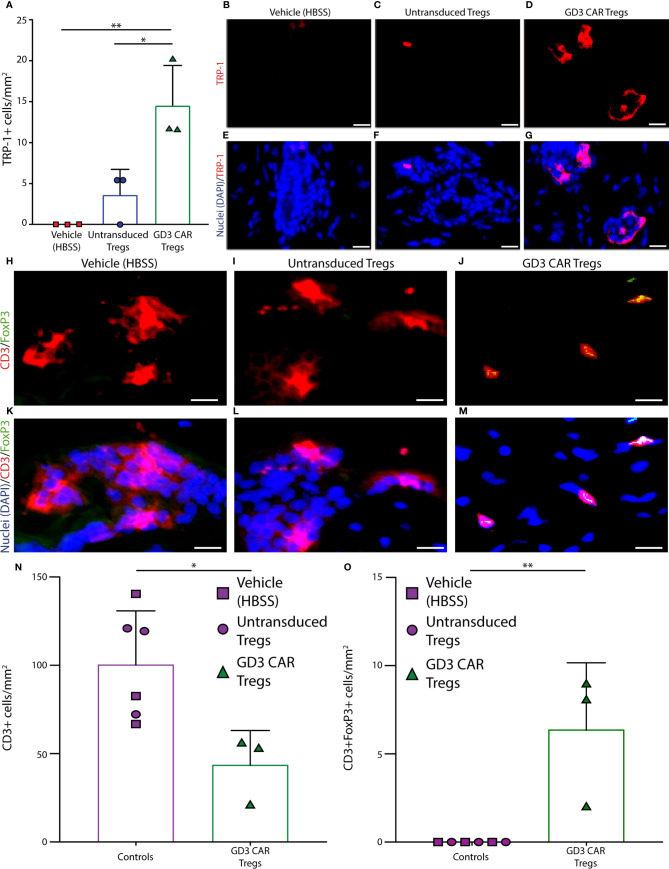
Melanocytes are protected from h3T cytotoxic T cells in the presence of GD3 reactive CAR Tregs. Mouse skin was evaluated for melanocyte presence using antibodies to TRP-1. (A) Quantification of melanocytes, as well as accompanying representative images of TRP-1 staining from (B) HBSS vehicle, (C) untransduced Tregs, and (D) GD3 CAR Tregs treated mice (n = 3 per group), with (E–G) the respective overlay including DAPI nuclear staining in blue is shown. Mouse skin tissues were also evaluated for T cell infiltration using antibodies to CD3ϵ and FoxP3, and examples of staining in skin from (H) vehicle control, (I) untransduced Tregs, and (J) GD3 CAR Tregs administered mice are shown. Representative samples were used to quantify CD3ϵ+ T cells (red), FoxP3+ cells (green), and double positive Tregs; (K–M) respective overlays with DAPI (blue) are also shown. Quantification of skin staining ± SD (n = 3 per group) for (N) T cells and (O) Tregs are shown, respectively. Statistical analysis was performed by non-parametric t tests. *p < 0.05, **p < 0.001 (Scale bar = 20 μm).